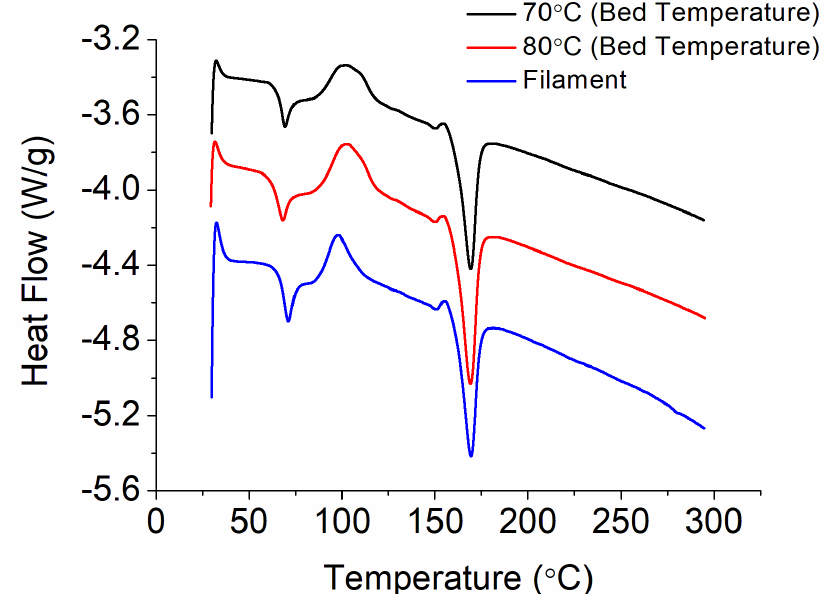
Figure 8. DSC curves of the CFR-PLA filament and CFR-PLA materials printed with different bed temperatures.